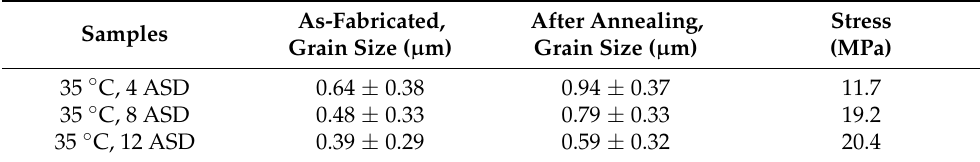
Table 5. Influence of grain size on the amount of stress